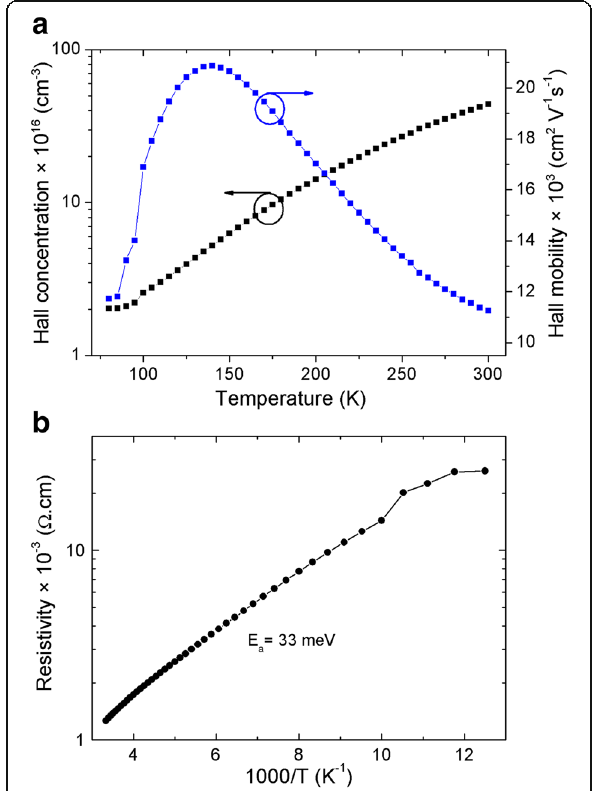
Fig. 5 a Hall concentration, Hall mobility, and b Hall resistivity of unintentionally doped LWIR InAs/GaSb T2SL. The transport properties of the LWIR InAs/GaSb T2SL. a Hall concentration and mobility: this superlattice exhibits only n -type conduction for the whole temperature range. The Hall concentration increases by increasing the temperature which is caused by the ionization effects. On the other hand, the Hall mobility behavior is governed by the different scattering mechanisms (phonons and ionized impurities) for temperatures higher than 95 K. For temperatures below 95 K, the mobility is constant (as well as the Hall concentration), which confirms the existence of another scattering mechanism which is